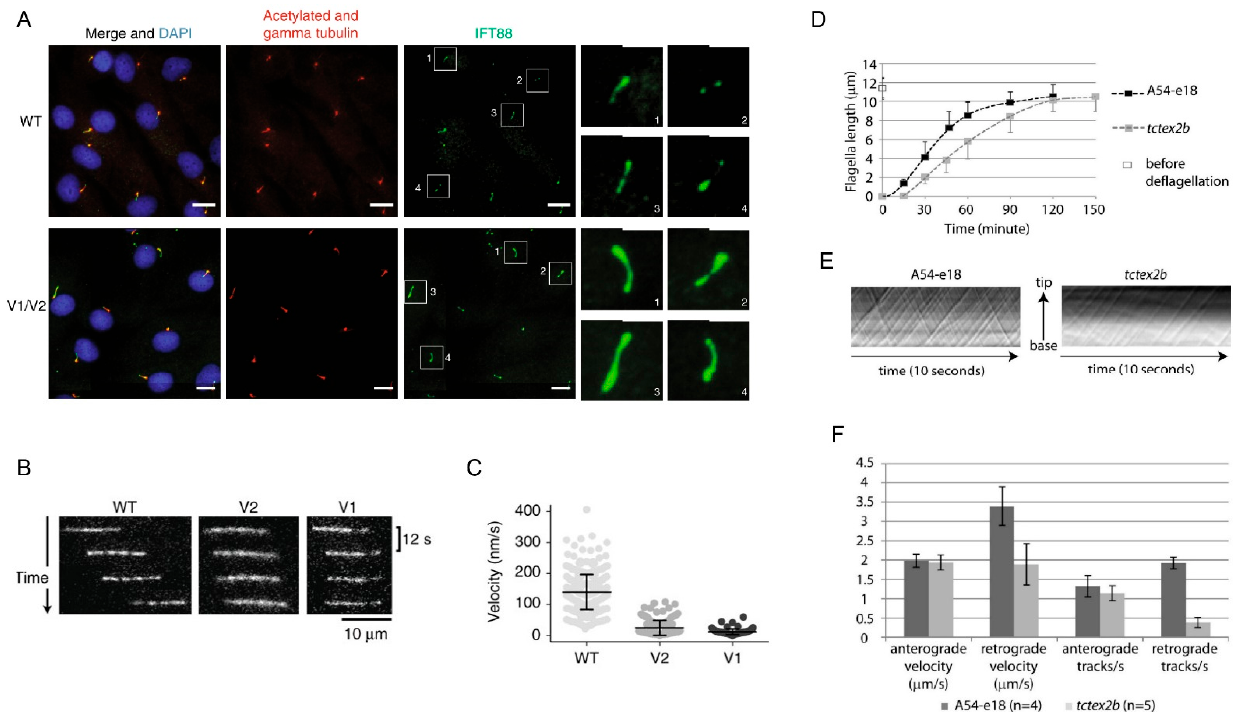
Figure 7. Ciliary defects observed in IFT dynein patients. ( A ) Bulged ciliary tips and accumulation of IFT particles at the ciliary tips in fibroblast cilia from an individual carrying DYNC2H1 mutations; enlarged images of the cilia marked in the white squares are shown on the right side with pictures numbered accordingly and ( B , C ) reduced tubulin velocity compared with the control, indicating impaired IFT, reprinted with permission from Vig et al. Genet Med. 2020 Dec;22(12):2041–2051 [137]. ( D ) Slower flagella extension, but similar flagella end length in Tctex2b mutant Chlamydomonas compared with controls suggests partial functional redundancy for Tctex2b. ( E ) Reduced but not absent retrograde IFT in Tctex2b mutants compared with controls. ( F ) Normal anterograde IFT velocity and unchanged number of anterograde IFT trains, but a reduction of the retrograde velocity and a strong reduction in the number of retrograde IFT trains in Tctex2b mutant Chlamydomonas compared with controls, reprinted with permission from Schmidts et al. Nat Commun. 2015 Jun 5;6: 7074 [133].